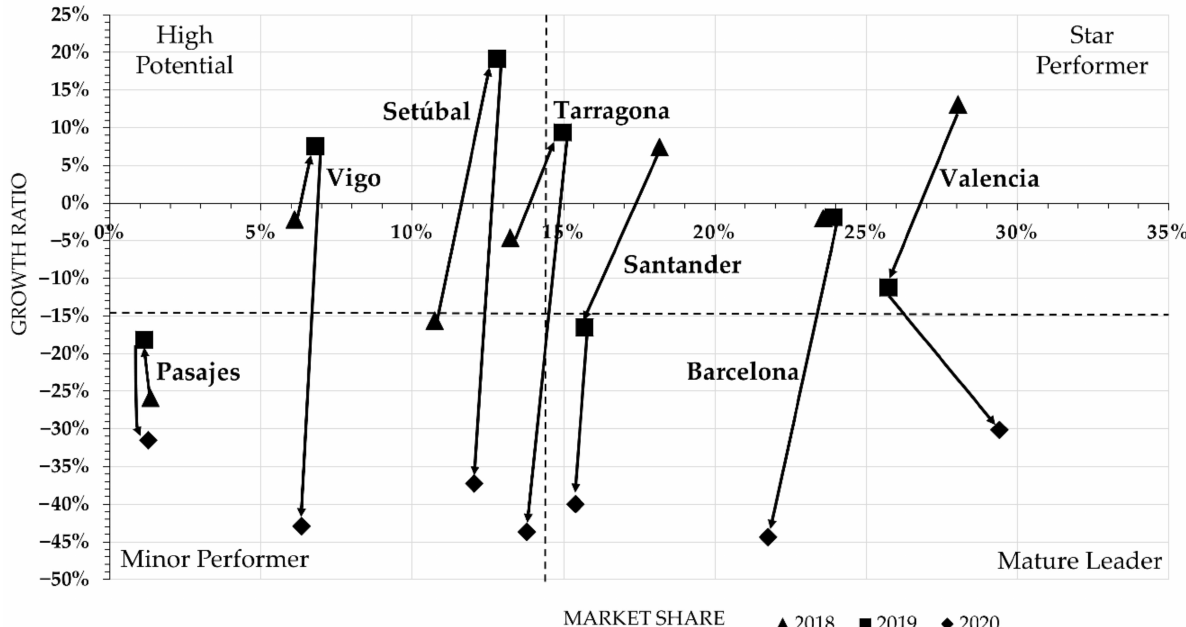
Figure 8. Matrix with dynamic portfolio analysis of port competitive positions for vehicle disembarking traffic during the period from 2018 to 2020.